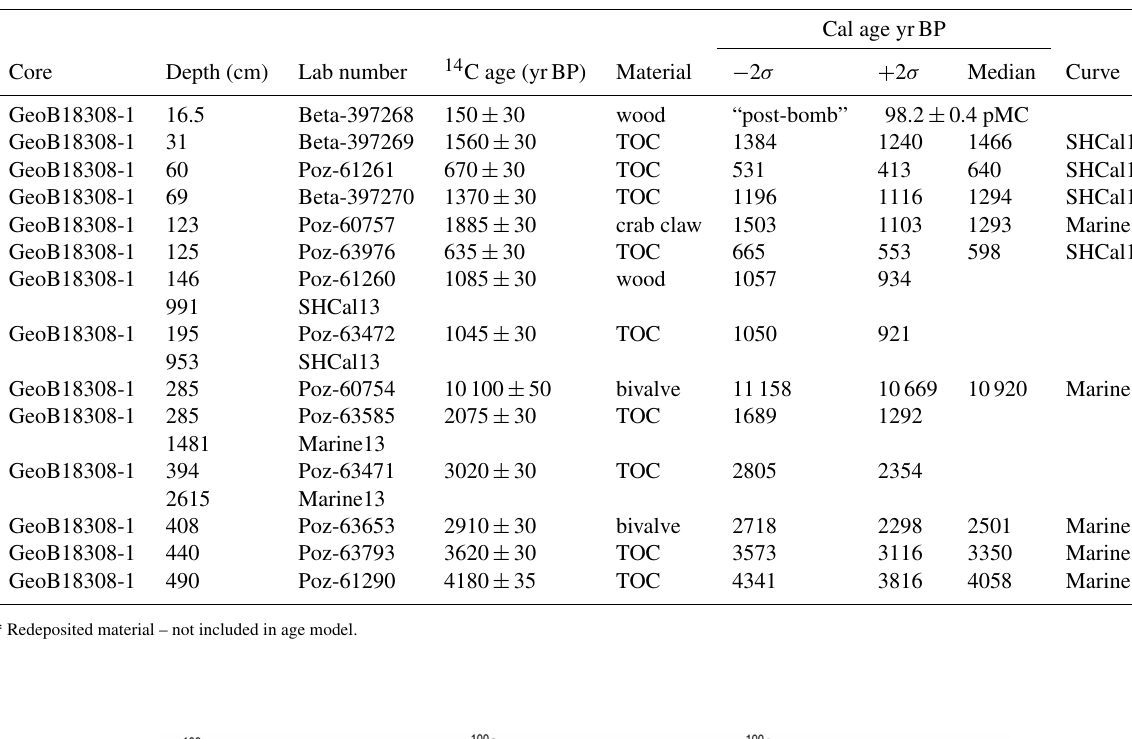
Table 1. AMS radiocarbon analyses of bulk TOC and carbonate material from core GeoB18308-1. Depending on sediment type (terrestrial or marine identified using all available data) the Southern Hemisphere calibration curve (SHCal13) (Hogg et al., 2013) or the modeled ocean average curve (Marine13) (Reimer et al., 2013) was used. To the latter a (cid:49) R of 146 ± 85 14 C (Dewar et al., 2012) was applied.